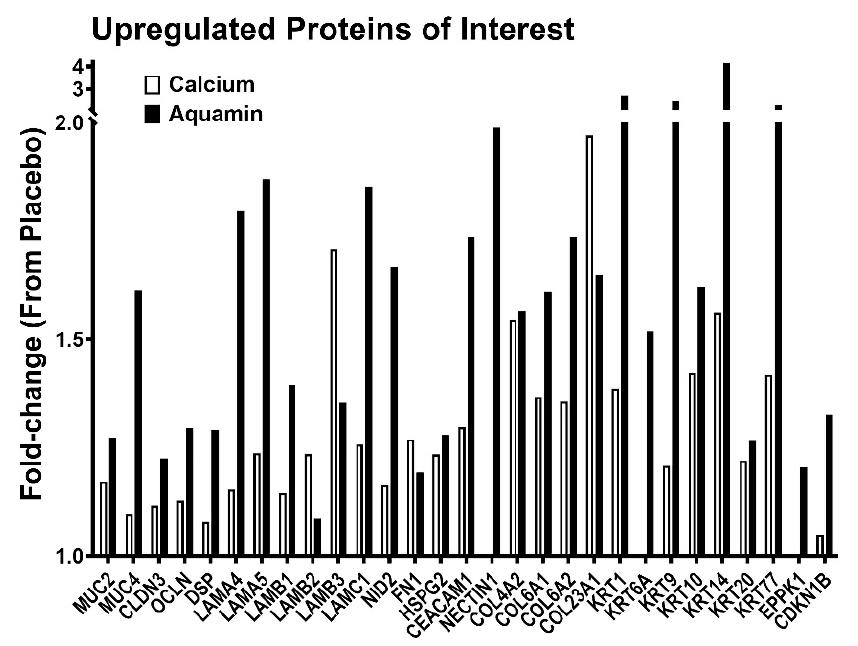
Figure 4. Upregulated proteins of interest. A fold-change value of each protein’s abundance ratio is presented in response to Aquamin ® and calcium interventions by comparing these to placebo. This pooled proteomic analysis was based on n = 10 subjects in each cohort.